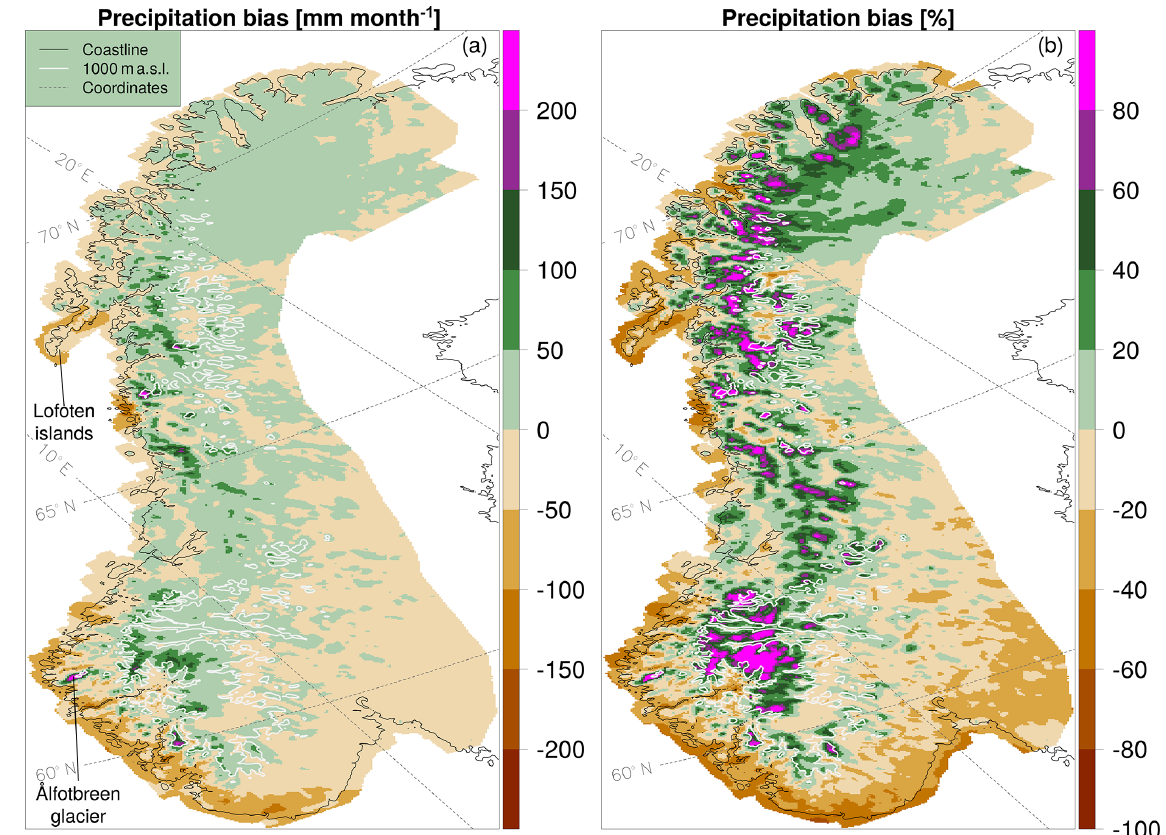
Figure 3. (a) Absolute and (b) relative precipitation differences between HCLIM38-AROME and seNorge for the time period